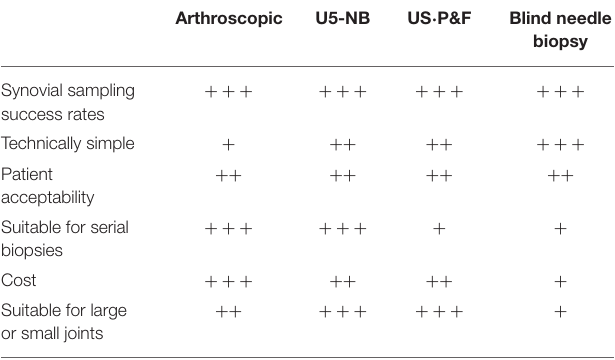
TABLE 1 | Considerations for selection of biopsy technique.